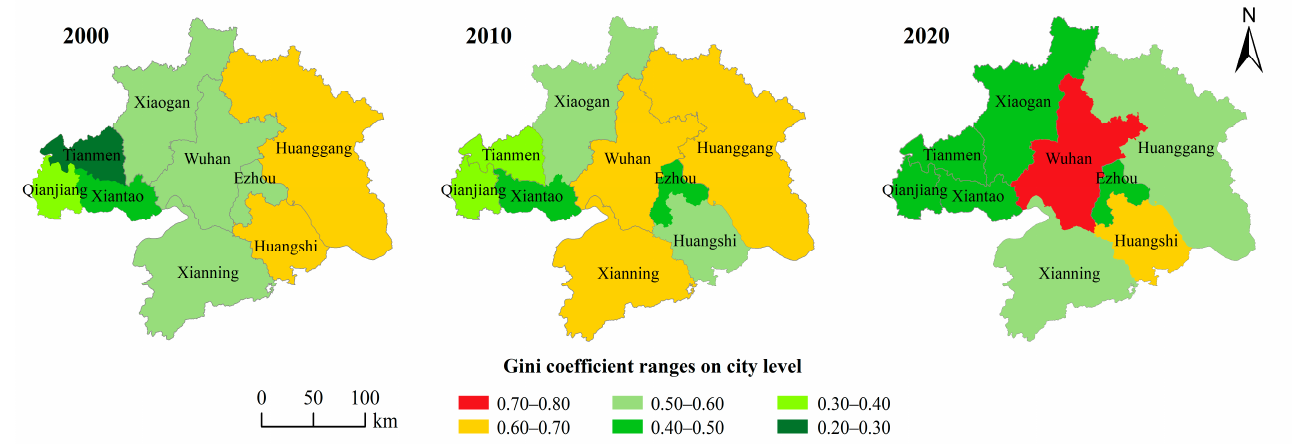
Figure 7. Gini coefficient ranges on city level.